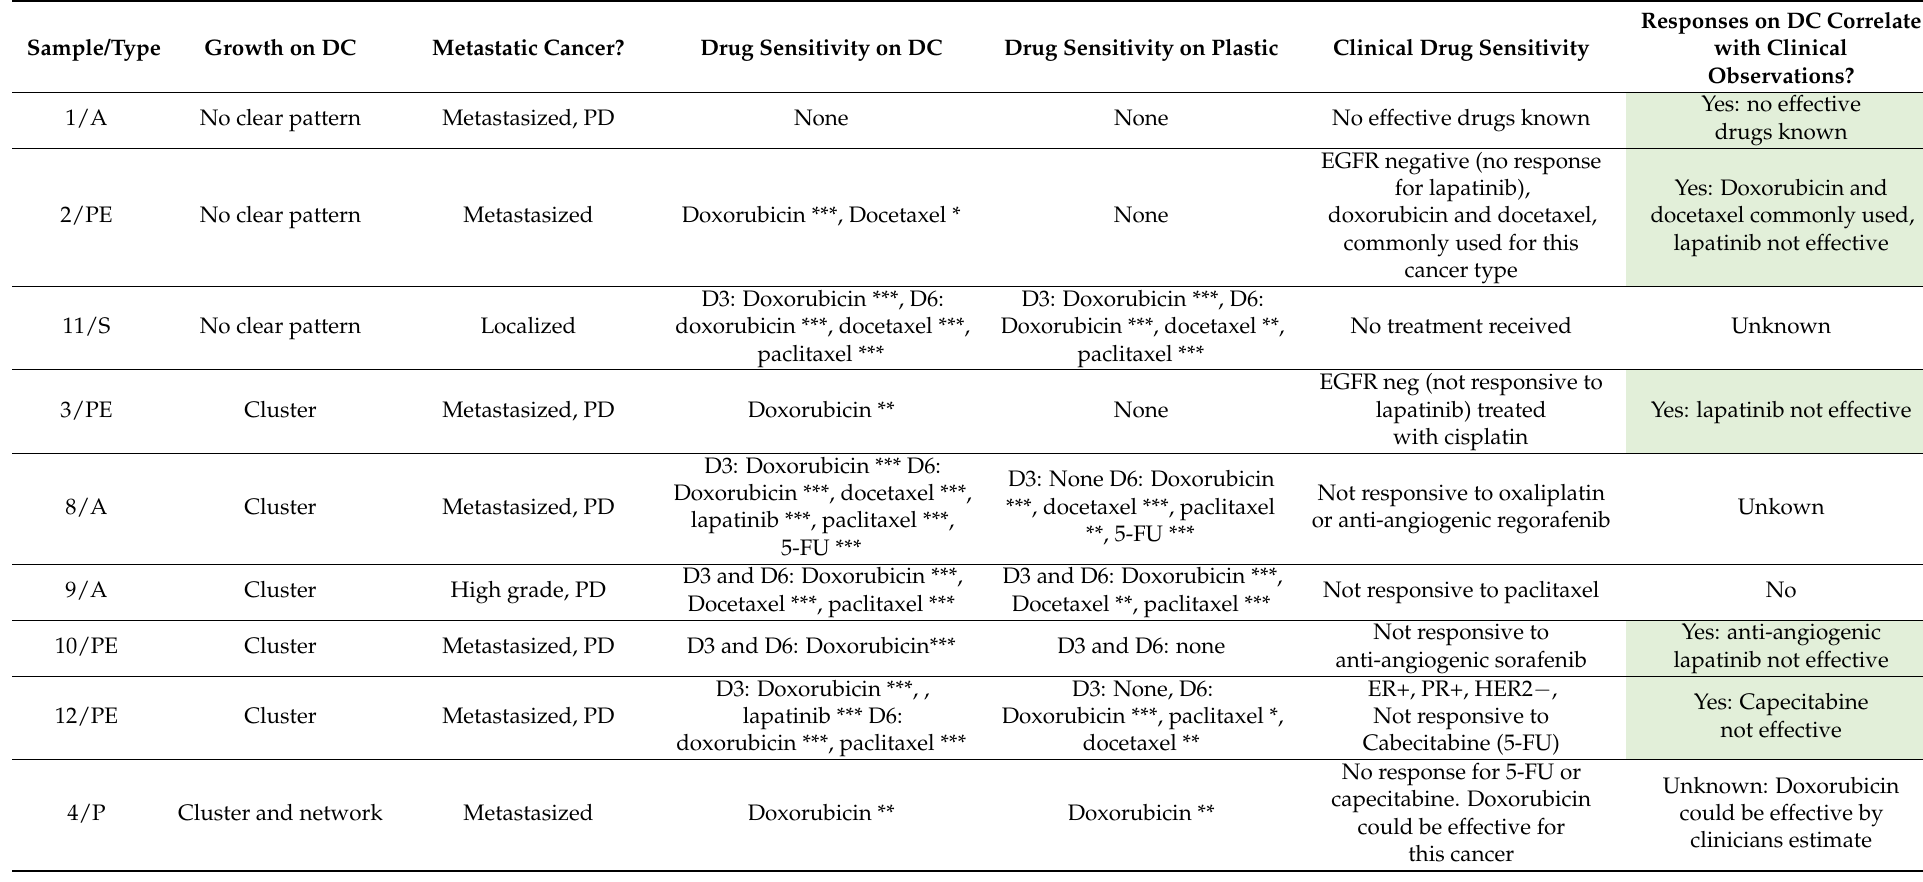
Table 6. The results from the patient-derived cancer cells. The growth patterns formed by the patient-derived cancer cells and responses of patient-derived cancer cells to selected drugs on plastic and on DC (after three-day or six-day treatment). All samples were analyzed after 3-day drug exposure and samples 8–14 also after 6-day drug exposure. Clinical data on the metastatic state and drug sensitivity is also listed. The correct correlation between results on DC and clinical responses